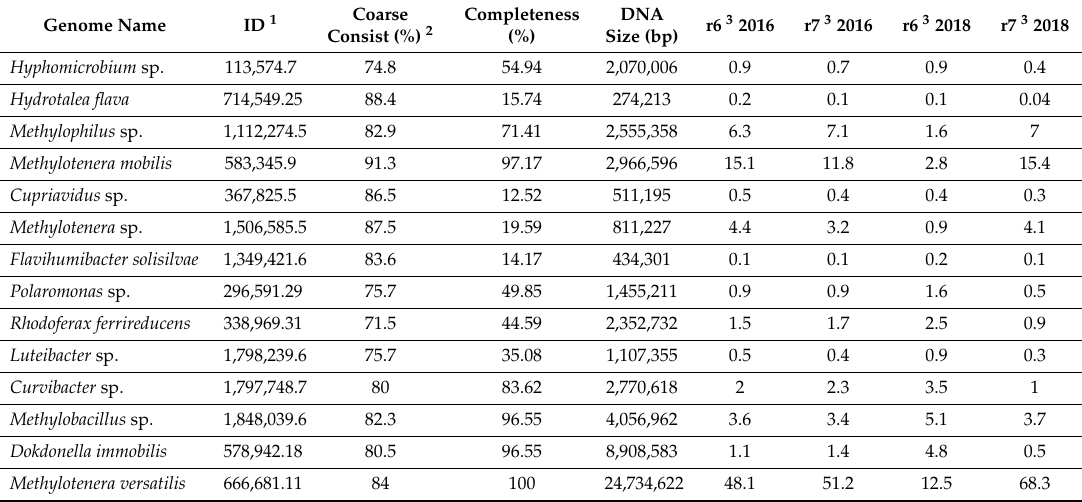
Table 1. Metagenome bins identified by PATRIC database binning